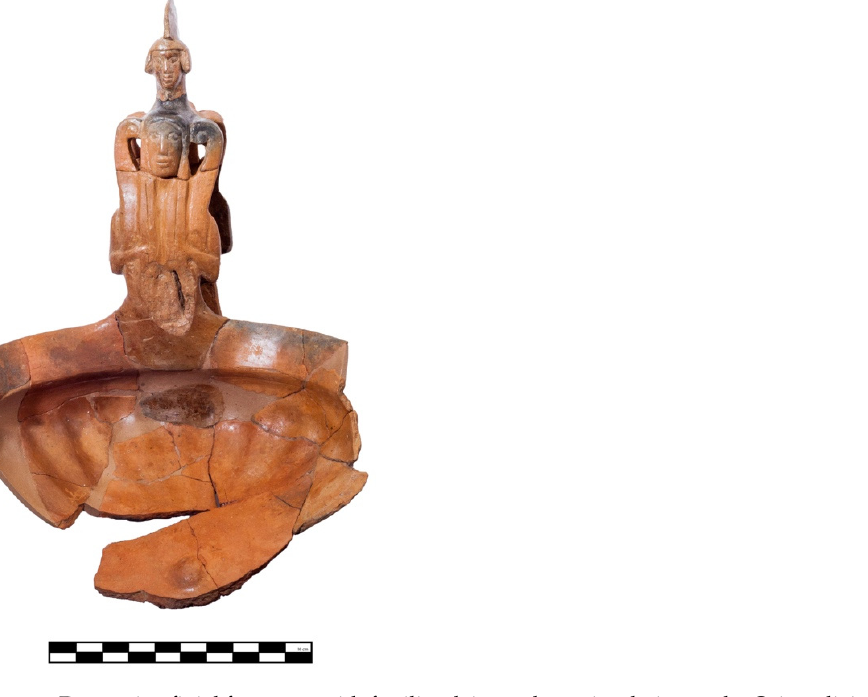
Figure 9. Decorative finial fragment with fertility deity and warrior dating to the Orientalizing Phase, 675/650–600 BCE (Image: Poggio Civitate Project).